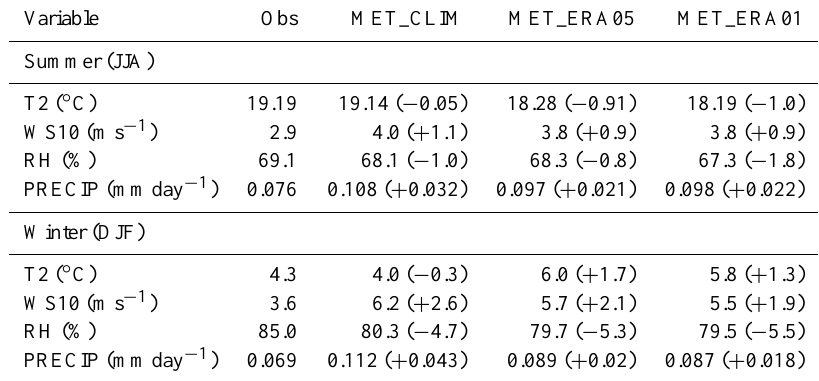
Table 2. Observed and modeled daily average meteorological variables over the Île-de-France region. MET_CLIM data set stems from a climate model and MET_ERA05, MET_ERA01 from reanalysis data at 0.5 and 0.1 ◦ resolution, respectively. Absolute model bias is given in